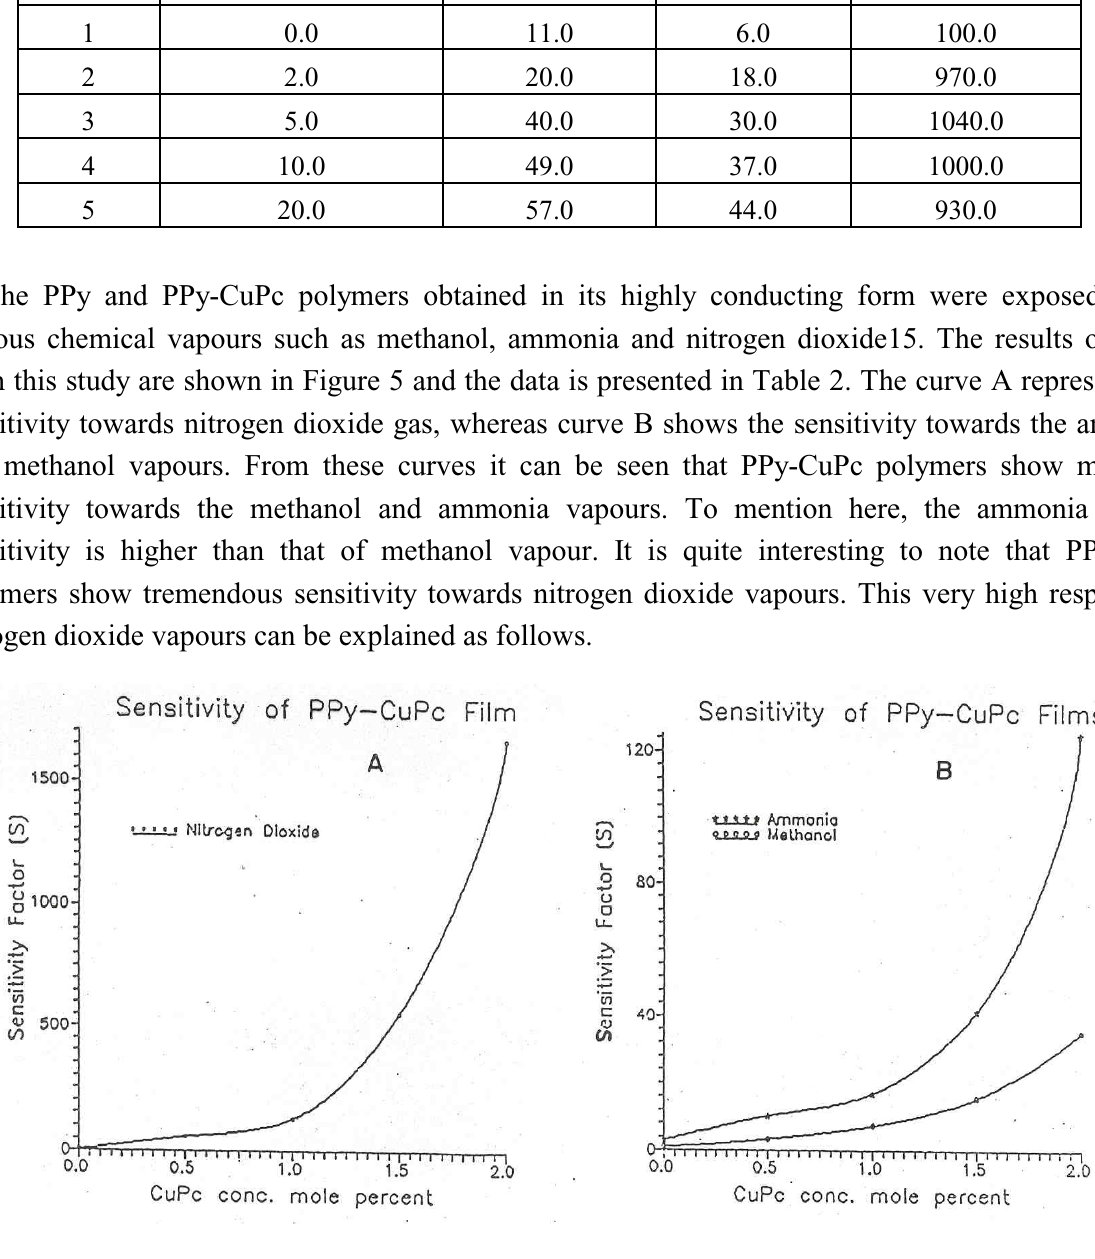
Figure 5. Plots of sensitivity factor versus CuPc concentration for PPy-CuPc polymers Nitrogen dioxide (B) Ammonia and